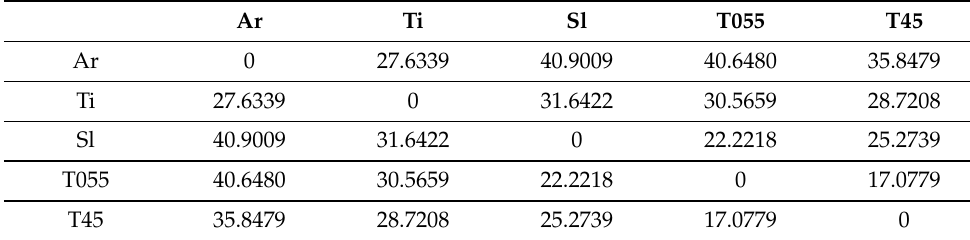
Table 3. Index of intensity match among five